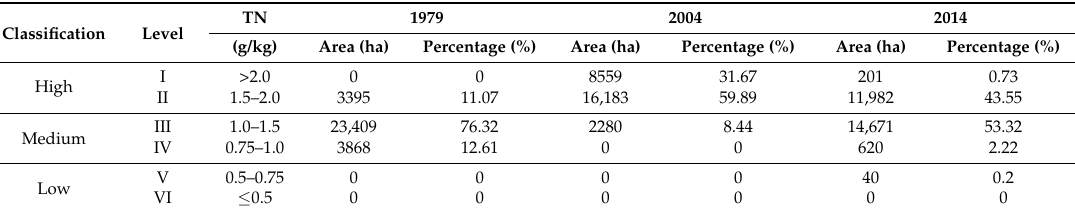
Table 5. Basic nutrients grades of soil